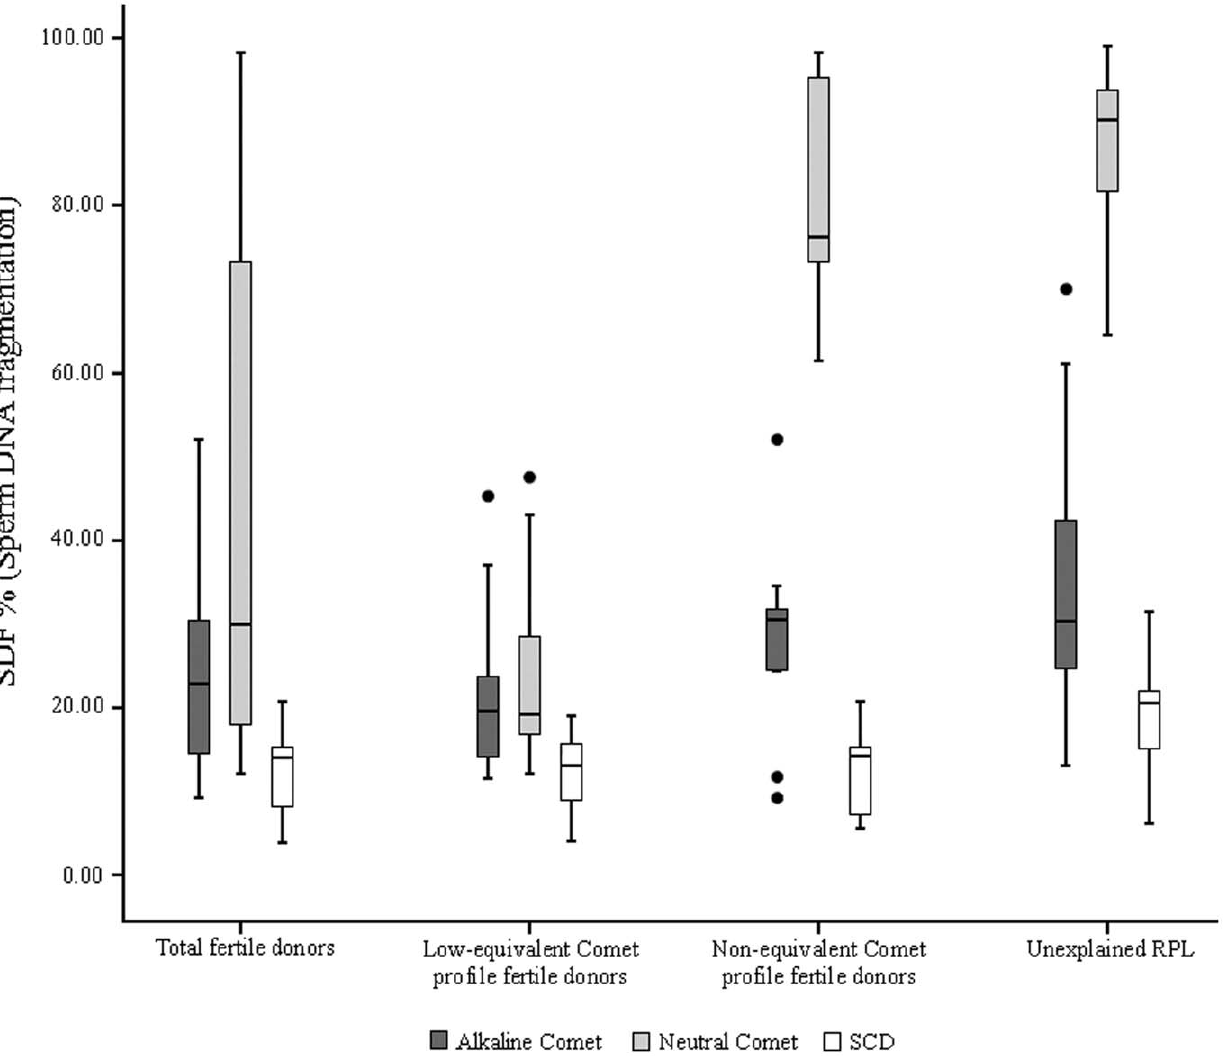
Figure 1. Alkaline Comet, neutral Comet and Sperm Chromatin Dispersion for total fertile donors, for low dsSDF and high dsSDF fertile donor subgroups and for the unexplained RPL group.